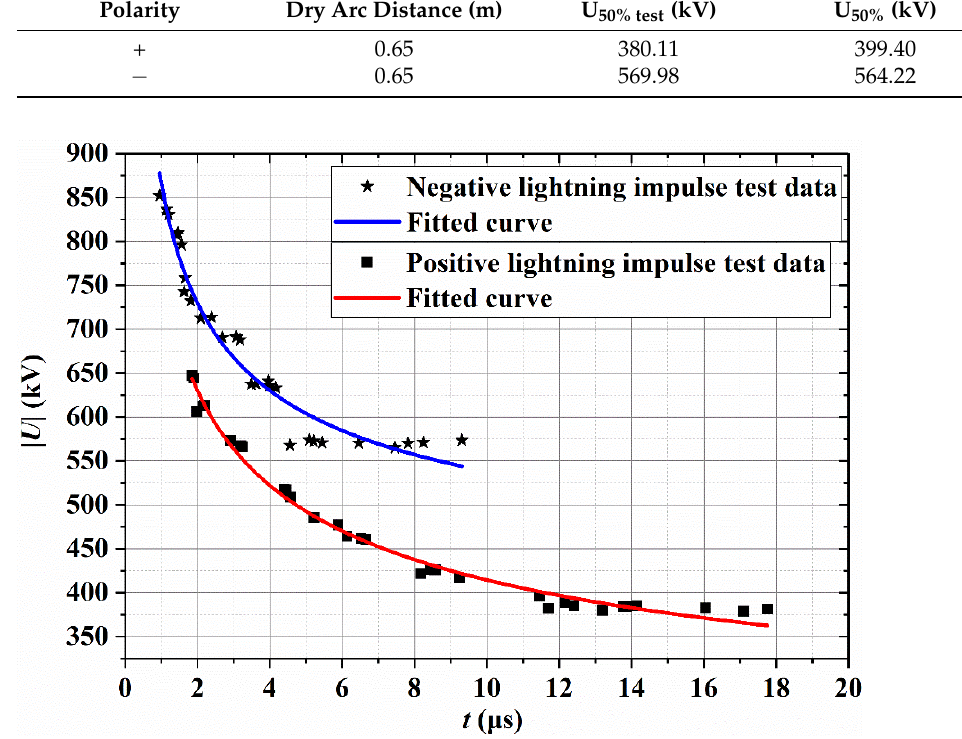
Figure 12. Positive- and negative-polarity volt-second characteristics. Table 2. Positive- and negative-polarity U 50% of Basalt fiber composite cross